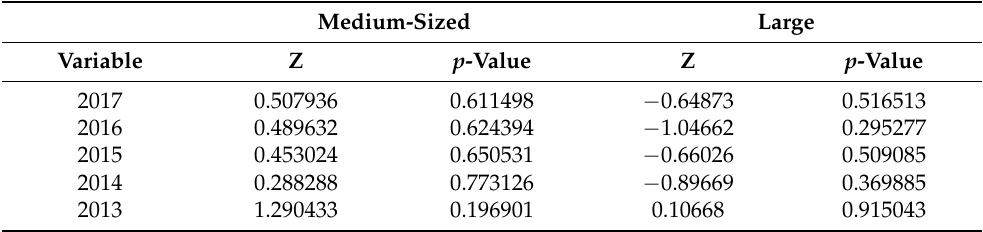
Table 5. Results of the Mann–Whitney U test for SLV in medium-sized